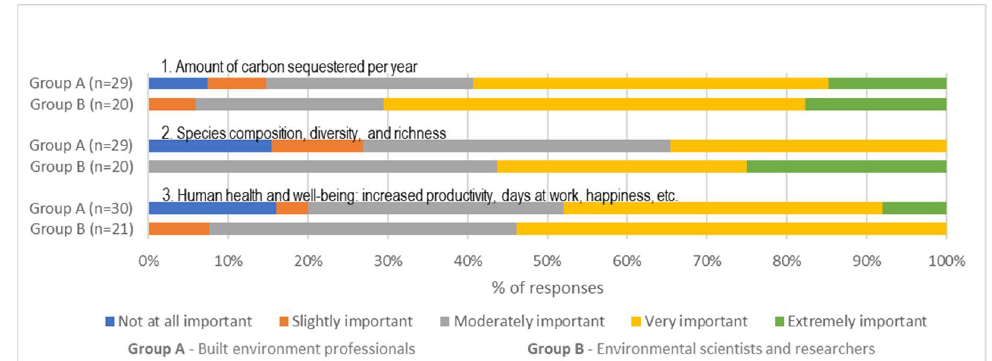
Figure 9. Performance indicators for assessing the success of building-related carbon sequestration strategies post-construction.